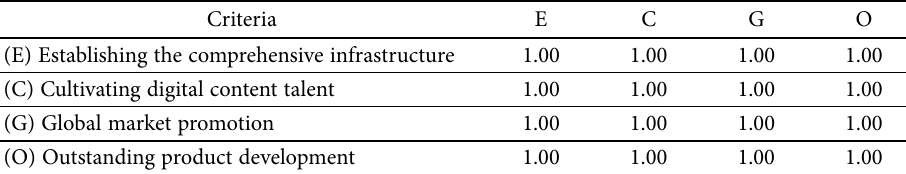
Table 4. The reachability matrix ( R * ) of all criteria